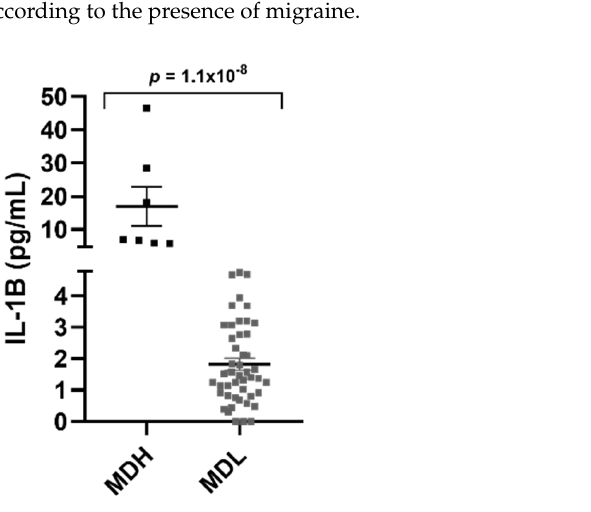
Figure 2. Scatter plots showing cytokine and chemokines levels in patients with MD, stratified ac- cording to the presence of migraine.